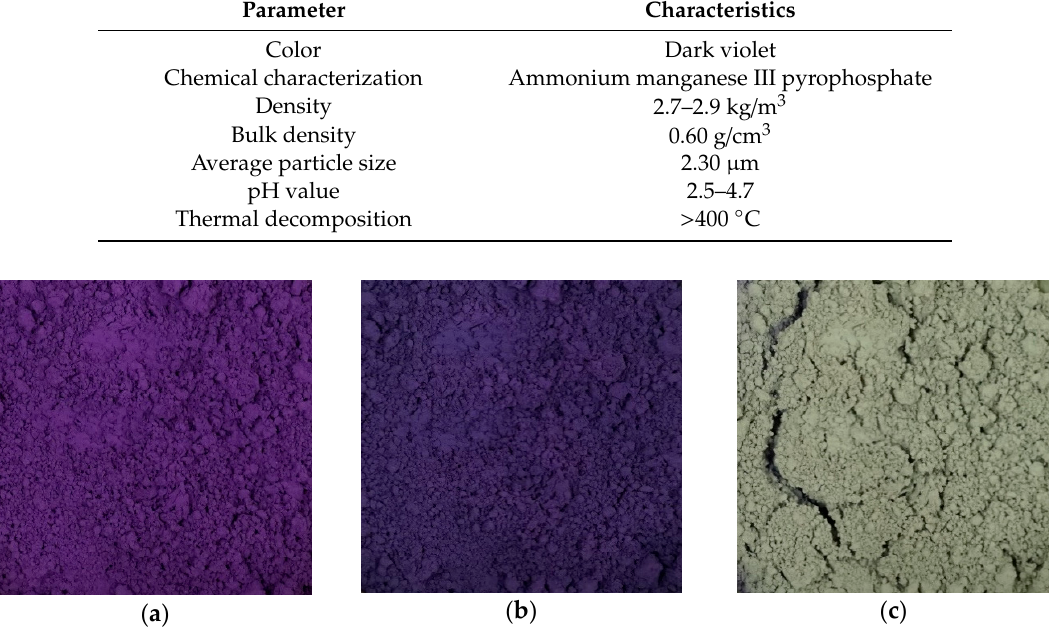
Figure 1. Color change of MnNH 4 P 2 O 7 pigment: ( a ) room temperature; ( b ) 370 °C; ( c ) 410 °C.